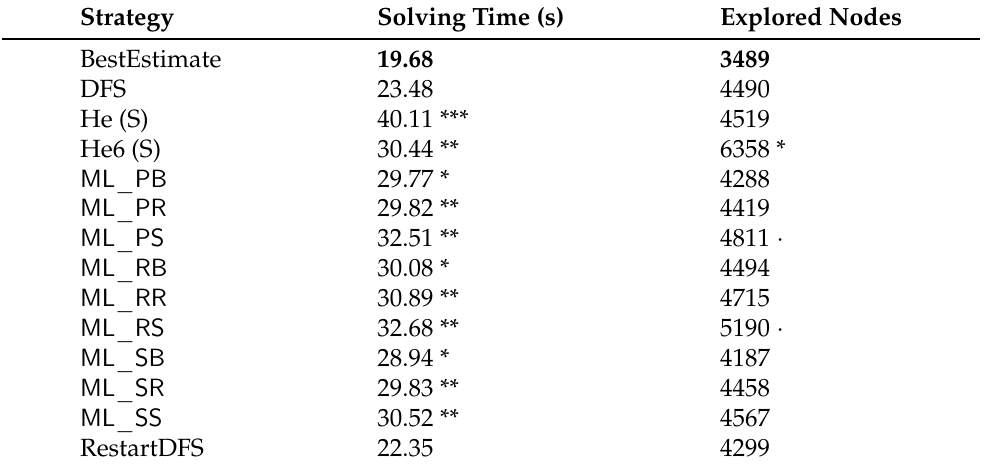
Table A5. Combinatorial auctions instances: average solving time and explored nodes for various node selection strategies. Pair-wise t -tests against BestEstimate : ‘***’ p < 0.001, ‘**’ p < 0.01, ‘*’ p < 0.05, ‘ · ’ p < 0.1.